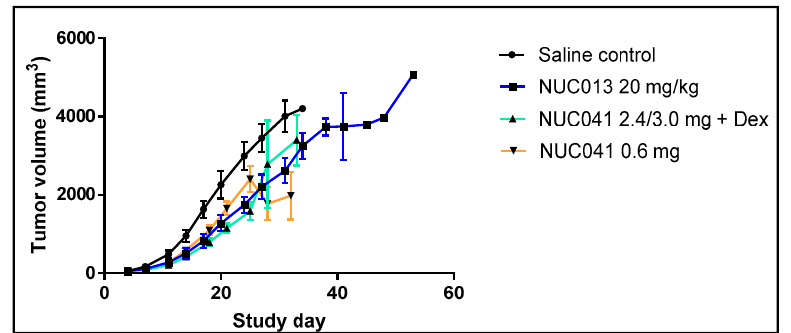
Figure 6. Comparison of mean tumor volumes ( ± SEM) in mice with human NSCLC NCI-H460 implants. Drug dose, route, and regimen as per Figure 5. Two mice in the NUC041 0.6 mg group had ulcerated tumors on study day 28 and should have been euthanized per protocol, but, by amendment, received additional doses of study drug on days 30 and 32 and were euthanized on study day 34 ( n = 10 per group).